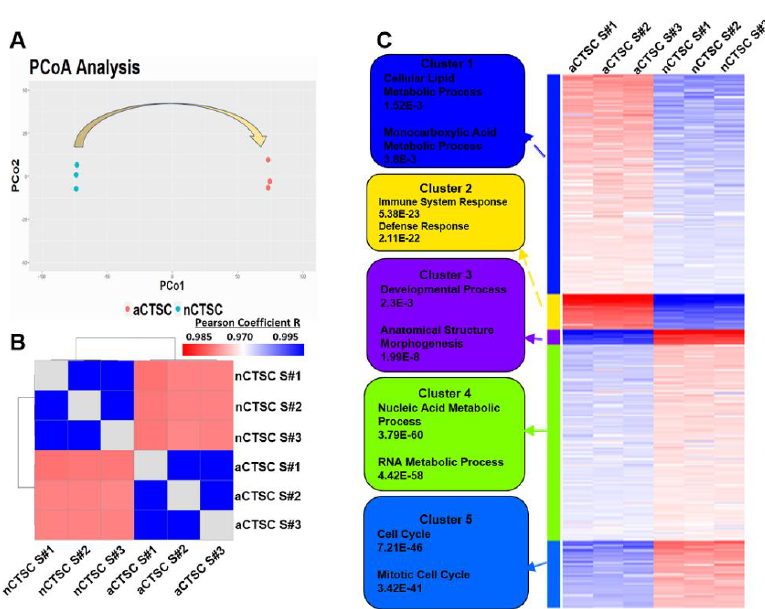
Figure 2. Distinct processes present in each cluster through Gene Ontology (GO) enrichment. ( A ) Principal coordinates analysis of transcriptomic data comparing the two samples. ( B ) Correlation matrix compares nCTSC with aCTSC using Pearson correlation coefficient. ( C ) Heatmap visualizing five clusters distinctly identified using elbow method and subjected to GO enrichment.